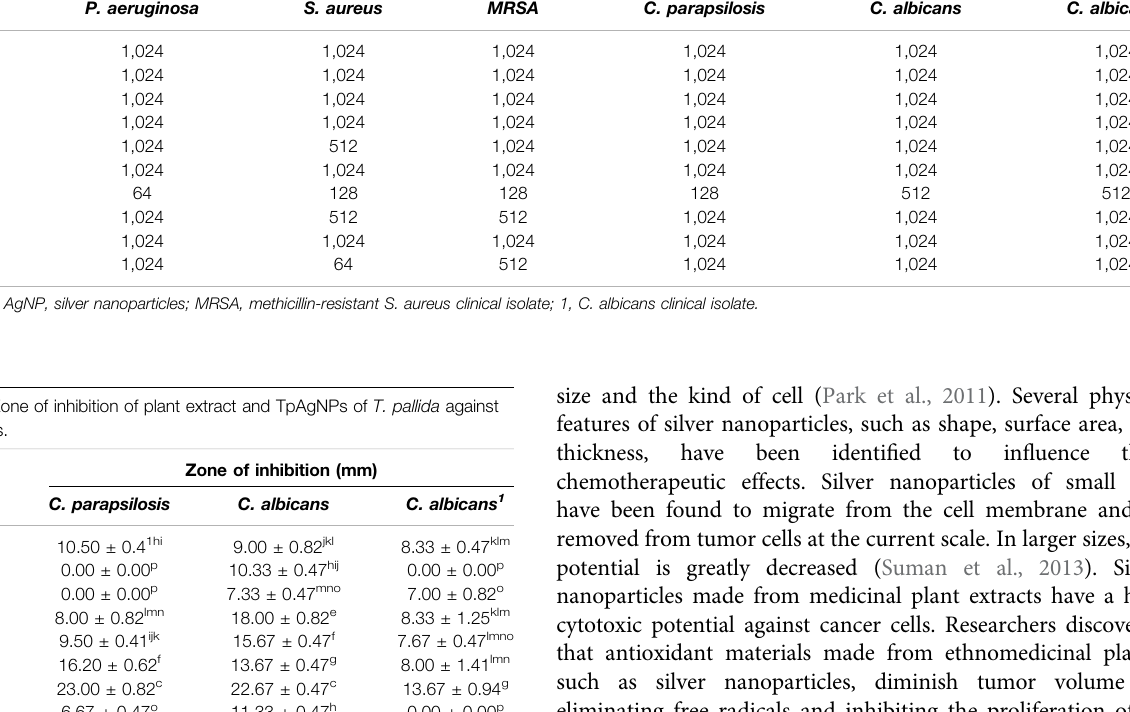
TABLE 4 | MIC of plant extract and TpAgNPs of T. pallida against different bacterial and fungal strains. Samples